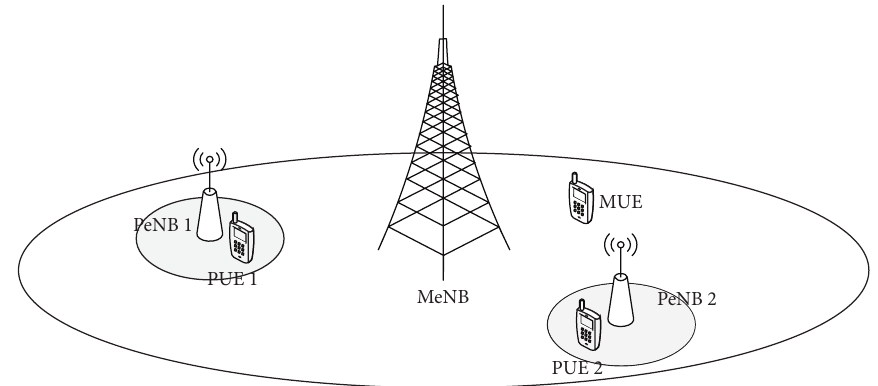
Figure 1: Uplink heterogeneous network composed of macrocell and